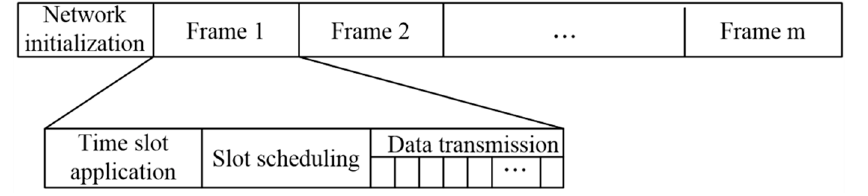
Figure 2. Frame structure.